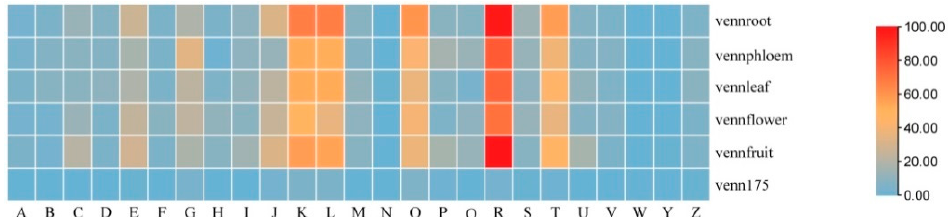
specific and prevalence expression of circRNAs. (The capital letters represent the function classifi- Figure 5. Cluster of genes (COG) classifications of parent genes (protein-based genes) of tissue